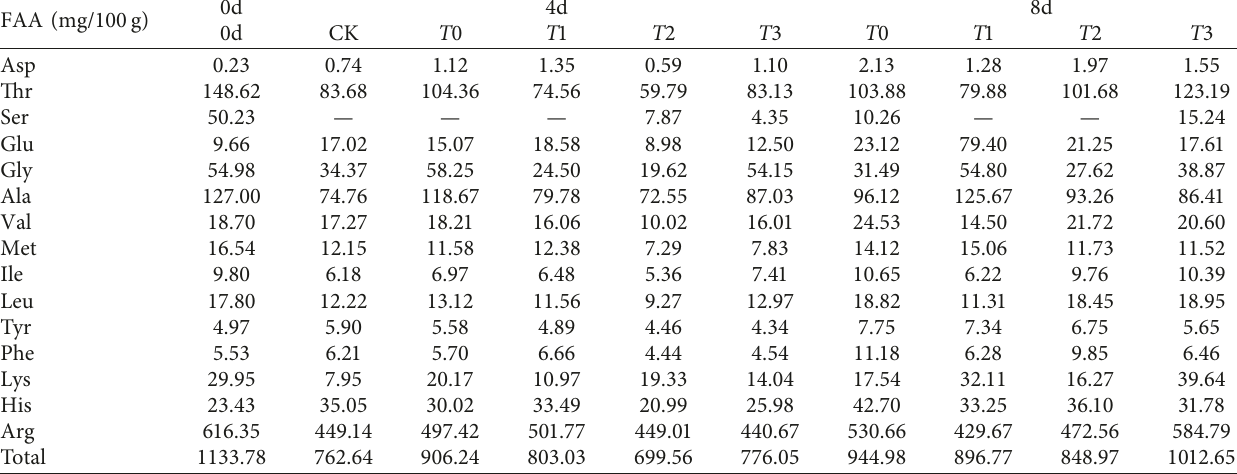
Table 2: FAA contents of crayfish sample during storage at 4 ° C.